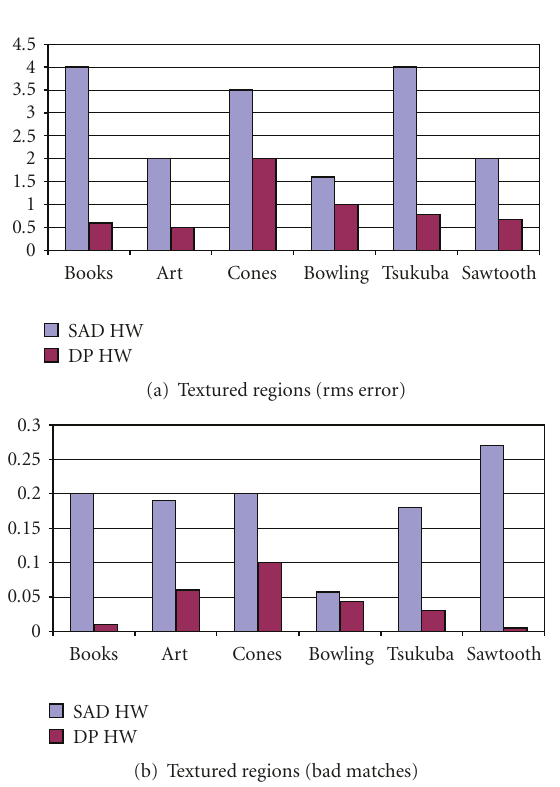
Figure 15: Errors computed in textured regions for the various data-sets. (a) rms error, (b) percentage of bad matching